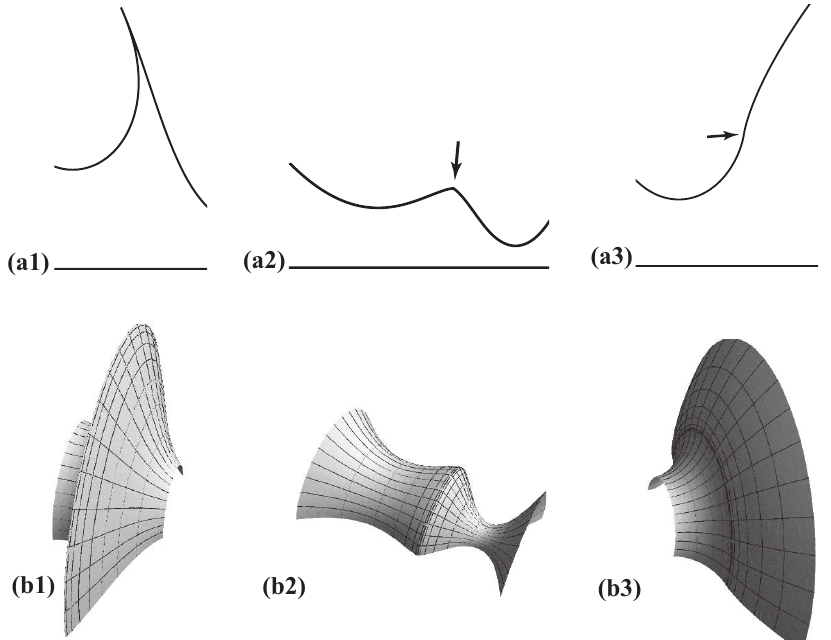
Figure 2 - Above: The generating curves of Example 2.5. The horizontal lines are the axes of rotation. Below: The surfaces of revolution of Example